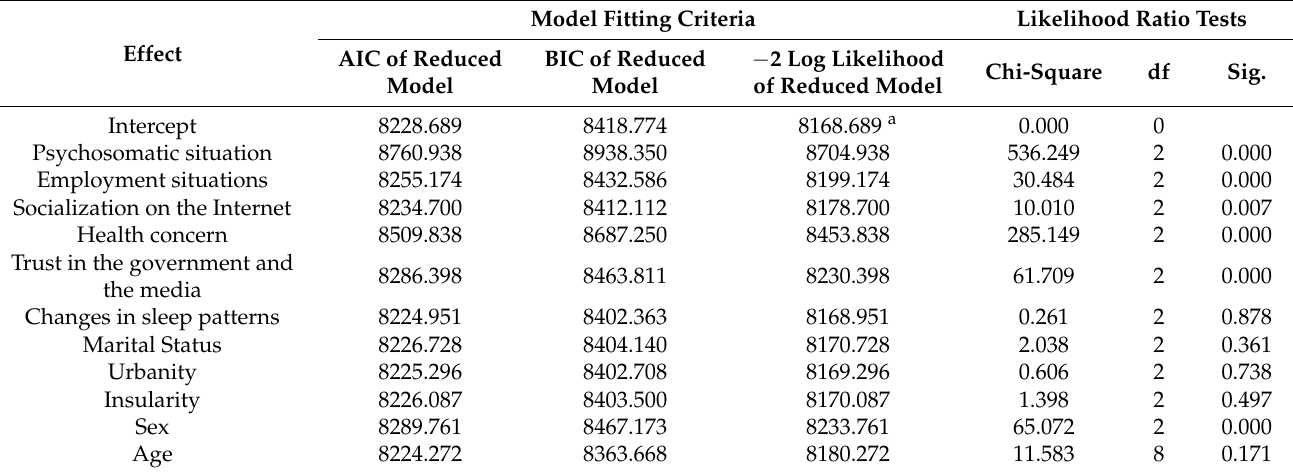
Table A3. Life satisfaction during lockdown, likelihood ratio tests—rejected